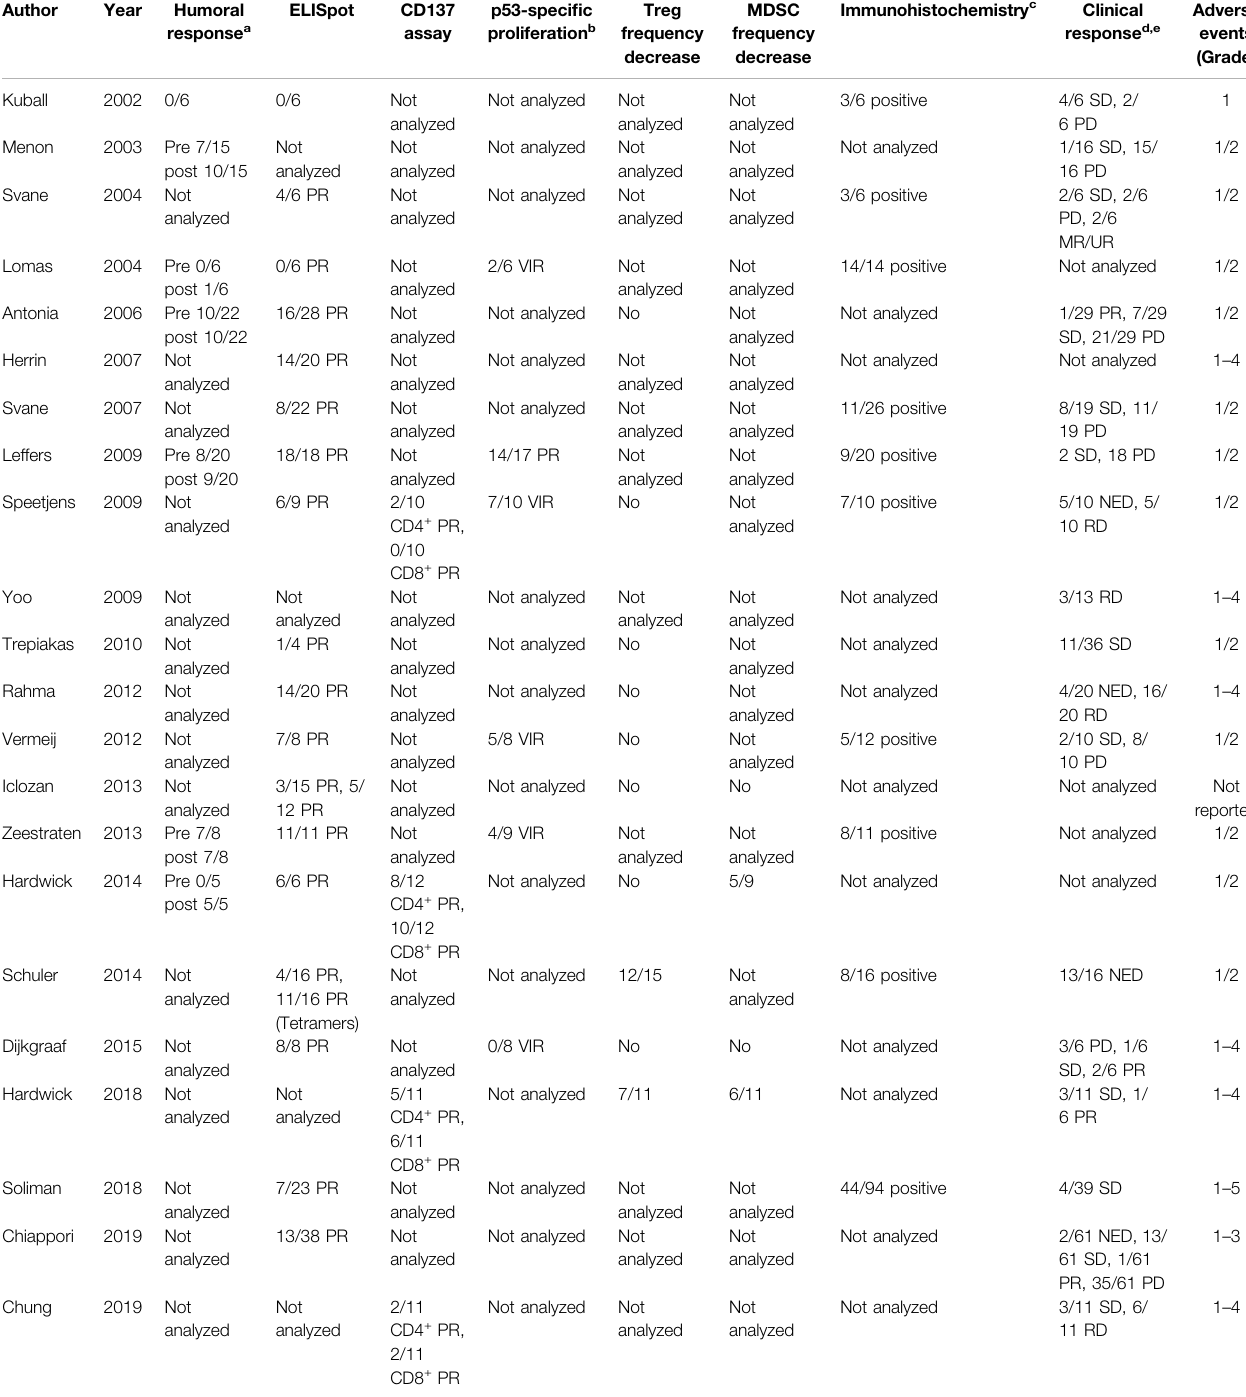
TABLE 2 | Immune and clinical response p53-targeting